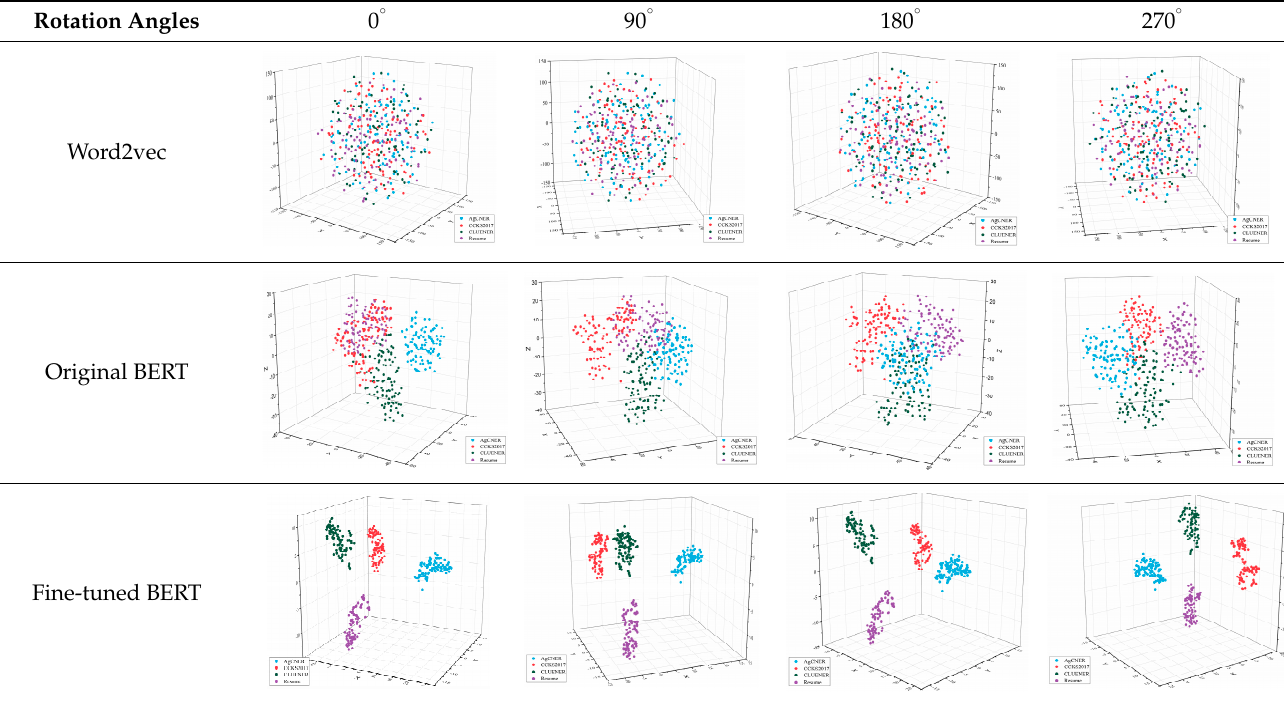
Table 8. Visualized results for each dataset.